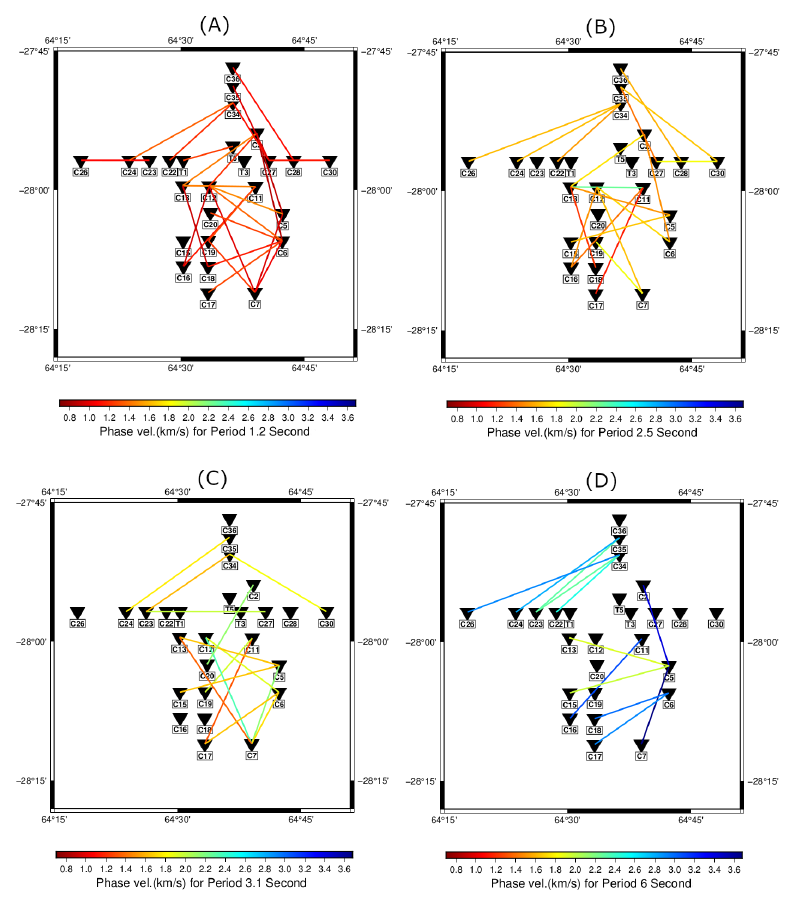
Figure 8. Phase velocity variations are indicated in ( A ) period 1.2 s, ( B ) period 2.1 s, ( C ) period 3.1 s, and ( D ) period 6 s. Reverse triangles indicate the location of the stations used in the final analysis. An increasing trend of the measured phase velocity from shorter to longer periods is